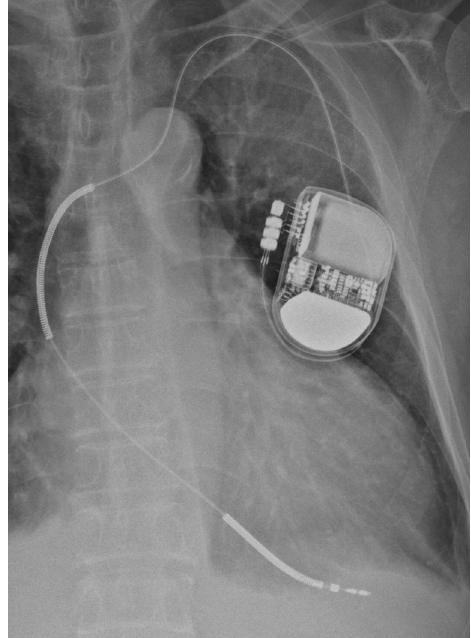
Fig. 13 The subcutaneous electrode is implanted in the left parasternal position. There is currently only one manufacturer with this device (Cameroon Health/Boston